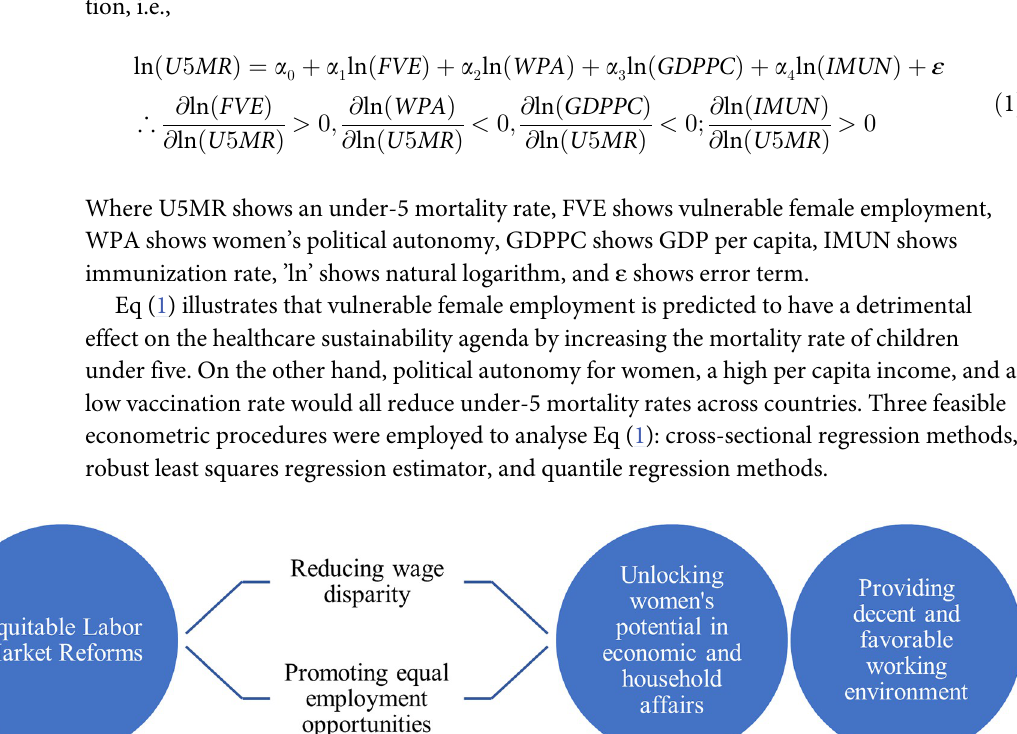
PLOS ONE | https://doi.org/10.1371/journal.pone.0269575 June 27,